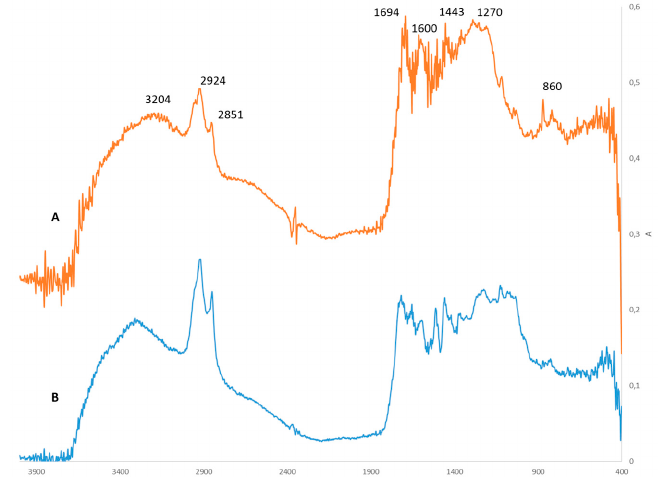
Figure 2. IR spectra of lignin obtained from biomass deconstruction in GVL/H 2 O ( A ) and dioxasolv lignin ( B ).